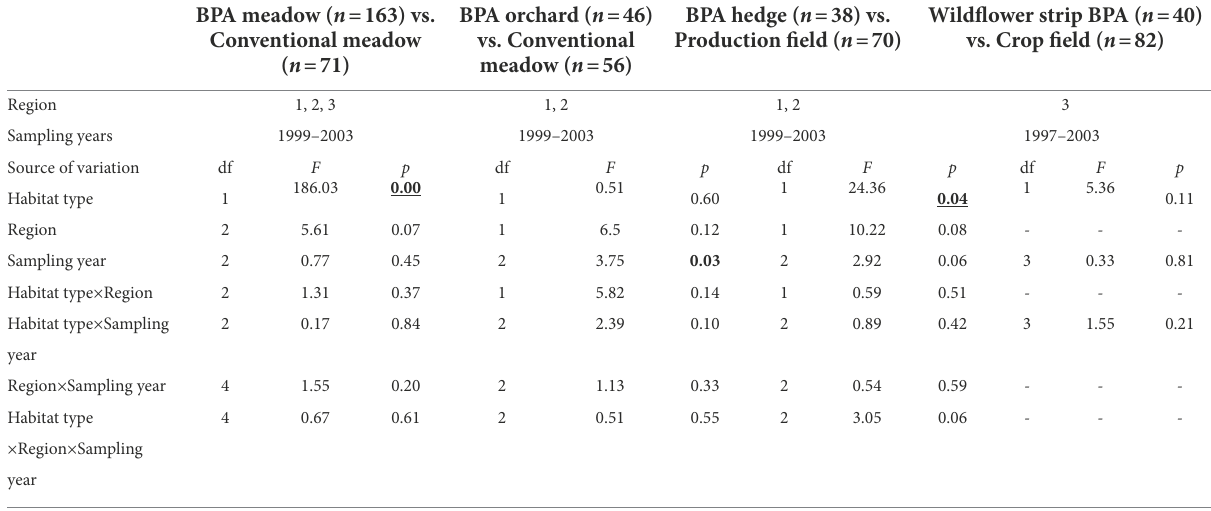
TABLE 3 Effects of habitat type pairwise (BPA habitat types vs. conventionally managed fields), region and sampling year on the multivariate dispersion of spiders in three regions of the Swiss plateau (mixed-model ANOVA with permutations). BPA meadow ( n = 163) vs. BPA orchard ( n = 46) Conventional meadow vs. ( n = 71)